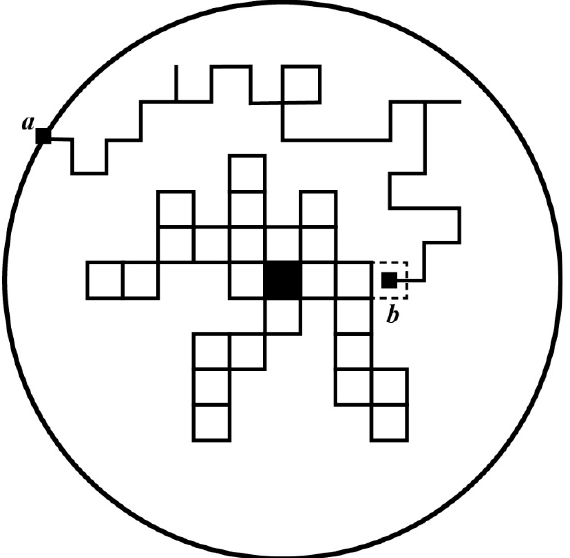
Figure 2. Growth rules of diffusion-limited aggregation (DLA) models.